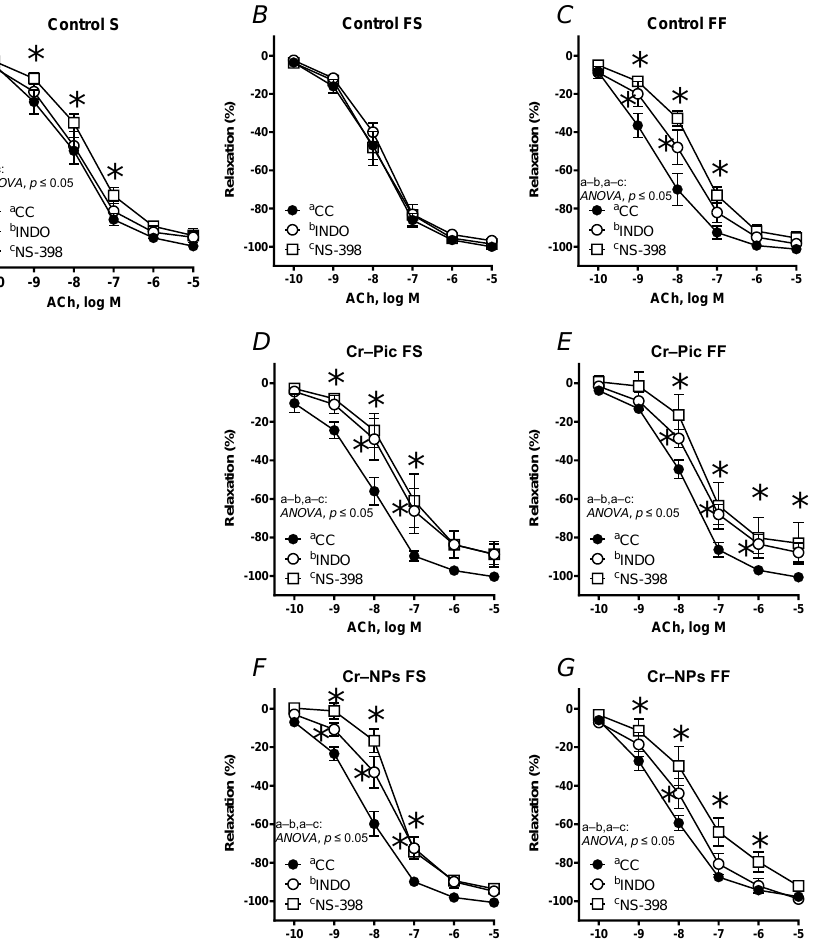
Figure 6. Effects of indomethacin (10 µM) and NS-398 (10 µM) on the concentration – response curves to acetylcholine (ACh) in aortic rings from the following groups of rats: control S ( A ), control FS ( B ), control FF ( C ), Cr – Pic FS ( D ), Cr – Pic FF ( E ), Cr – NPs FS ( F ), and Cr – NPs FF ( G ). 0.3 mg Cr/kg of body weight as chromium picolinate (Cr – Pic) and chromium nanoparticles (Cr – NPs) were added